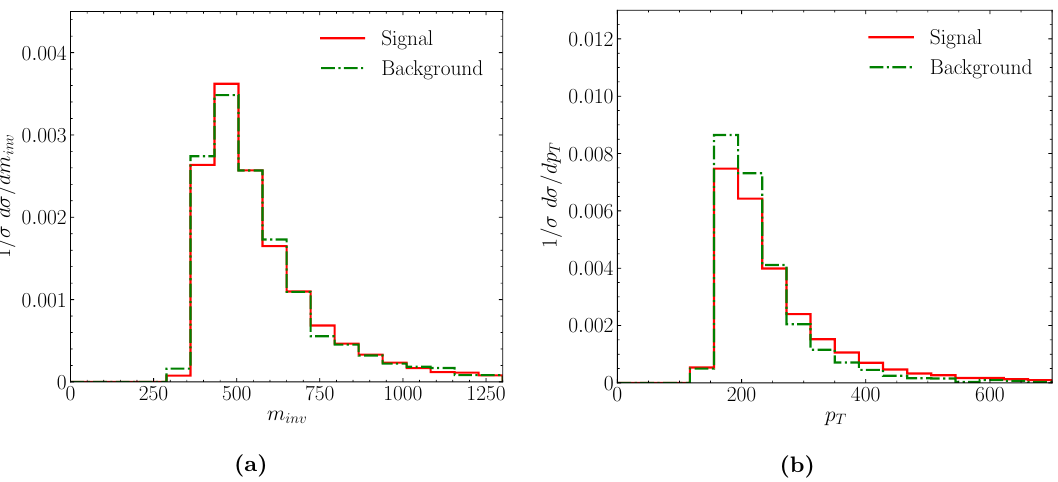
Figure 1. (a) shows the invariant mass of the leptons and fat jet while (b) shows the transverse momentum of the fat